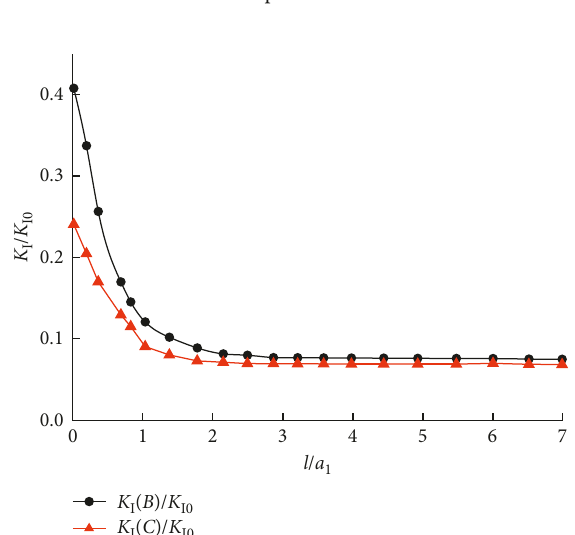
Figure 6: Computation of the SIF for the interacted wing crack tip by using the superposition technique.